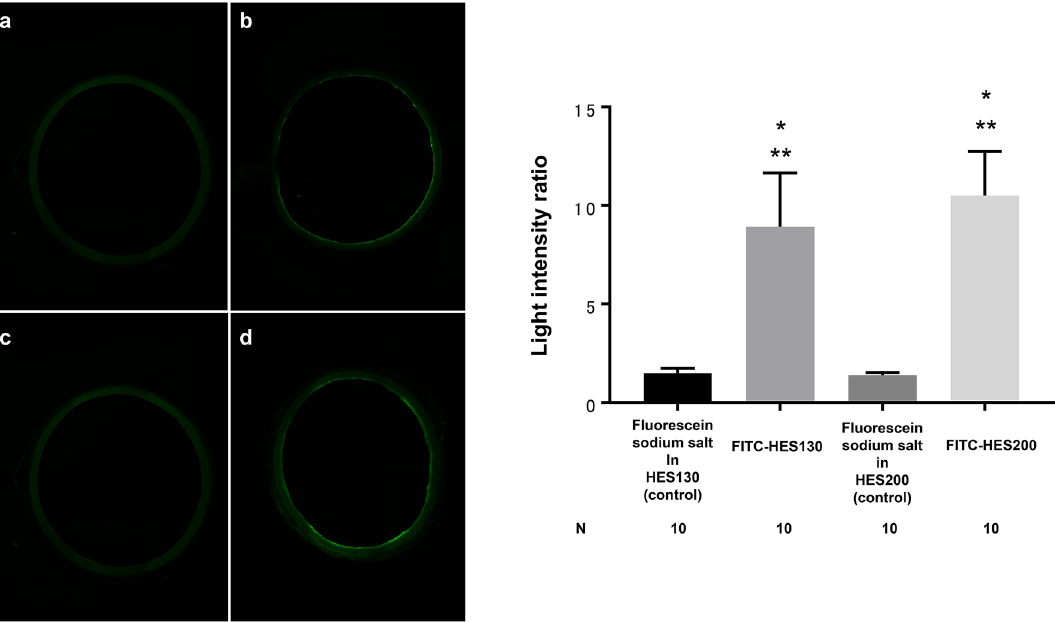
Figure 7. Left: Representative cross-sectional images of the isolated aorta after infusion of fluorescently labeled HES. ( a ) Fluorescein sodium salt in HES130 (control), ( b ) FITC-HES130, ( c ) fluorescein sodium salt in HES200 (control), ( d ) FITC-HES200. Right: Luminance intensity ratio of endothelium to outer membrane after infusion of fluorescently labeled HES in the isolated aorta. HES130 6% hydroxyethyl starch 130/0.4 in PS (6% Voluven), HES200 10% hydroxyethyl starch 200/0.5 in PS (10% Pentaspan), FITC fluorescein isothiocyanate. *P < 0.0001 vs fluorescein sodium salt in HES130 (control), **P < 0.0001 vs fluorescein sodium salt in HES200